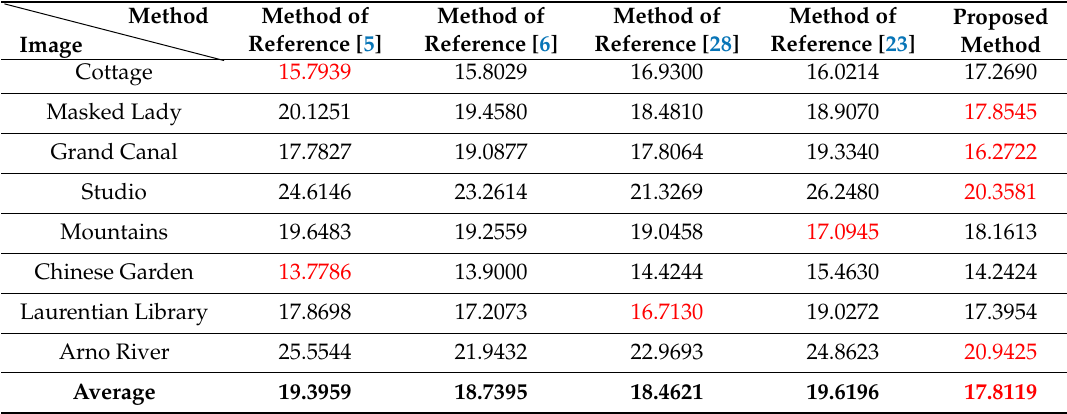
Table 5. Comparison of the five methods in terms of IL-NIQE [41].